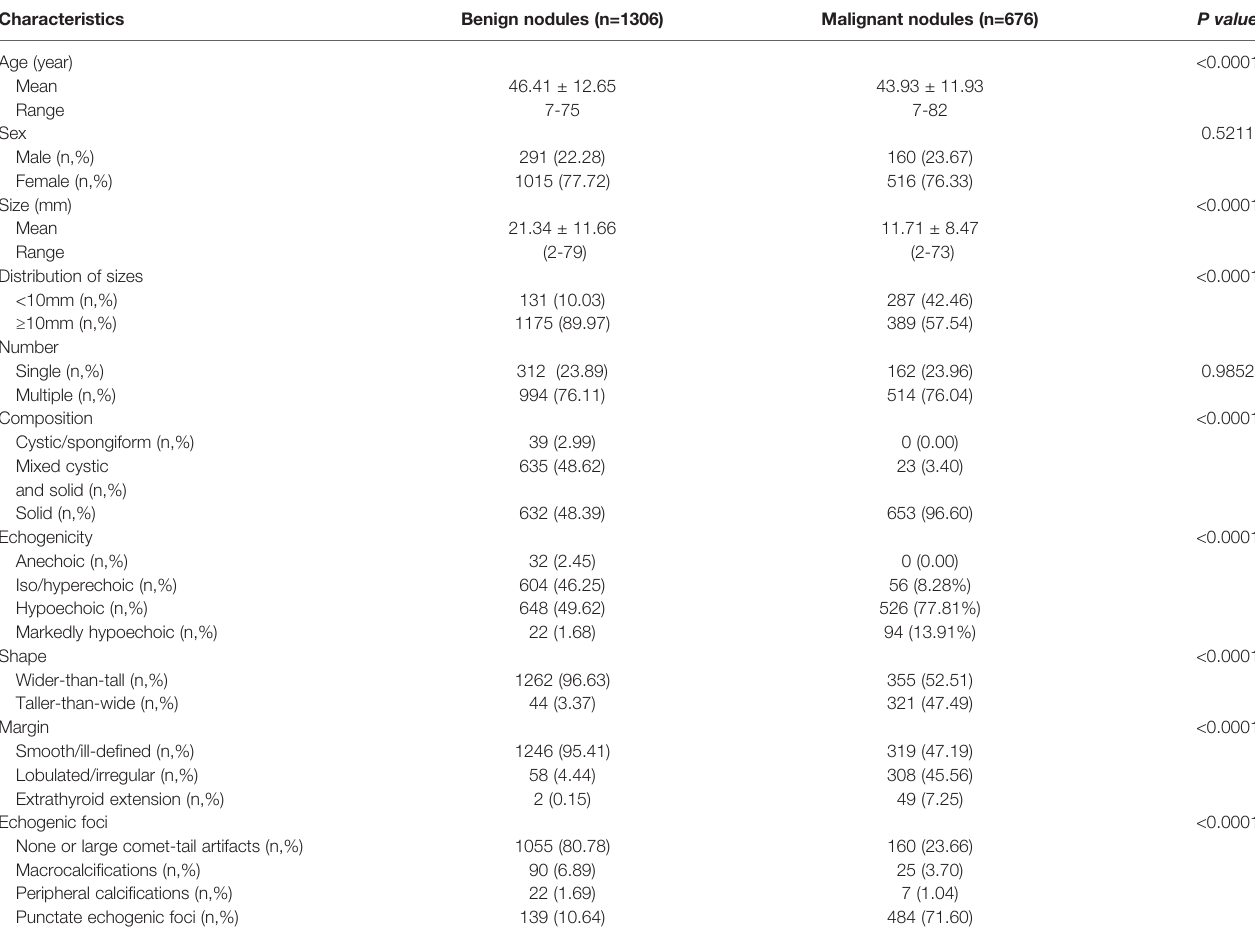
TABLE 1 | Demographic and ultrasound features of the patients with thyroid nodules. Characteristics